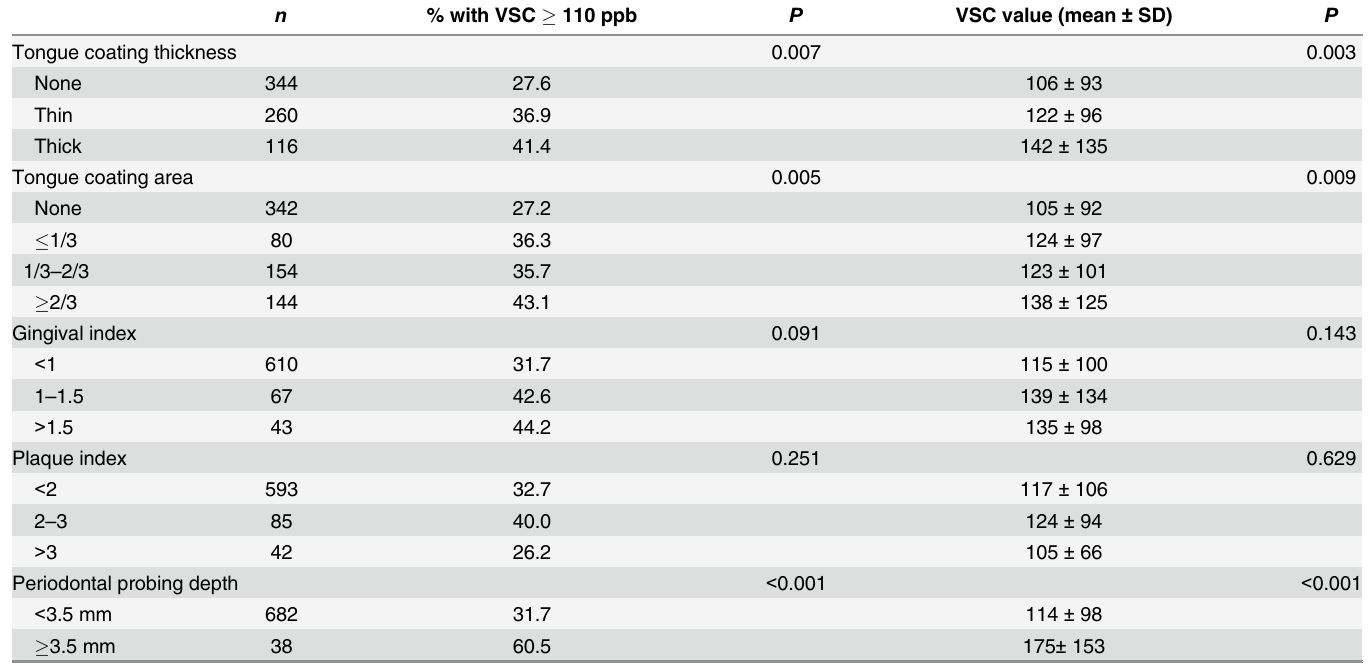
Table 2. Relationships between oral malodor measurements and clinical factors #